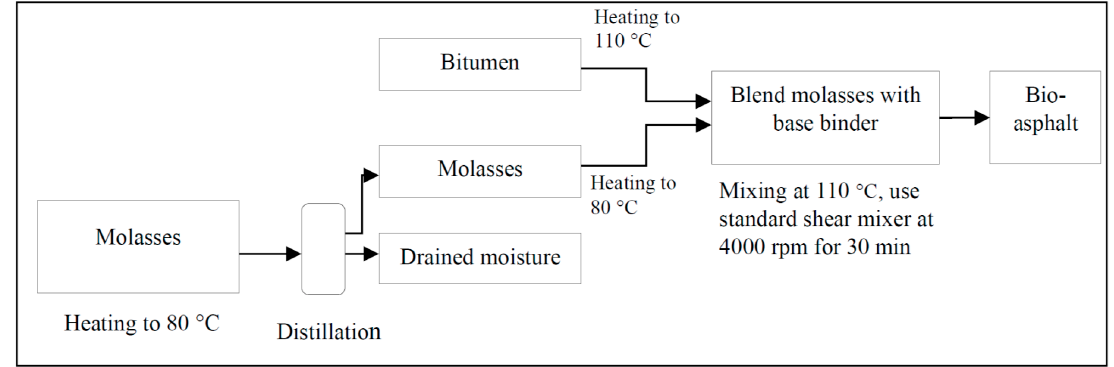
Figure 3. Modified bio-binder (MMB) preparation.